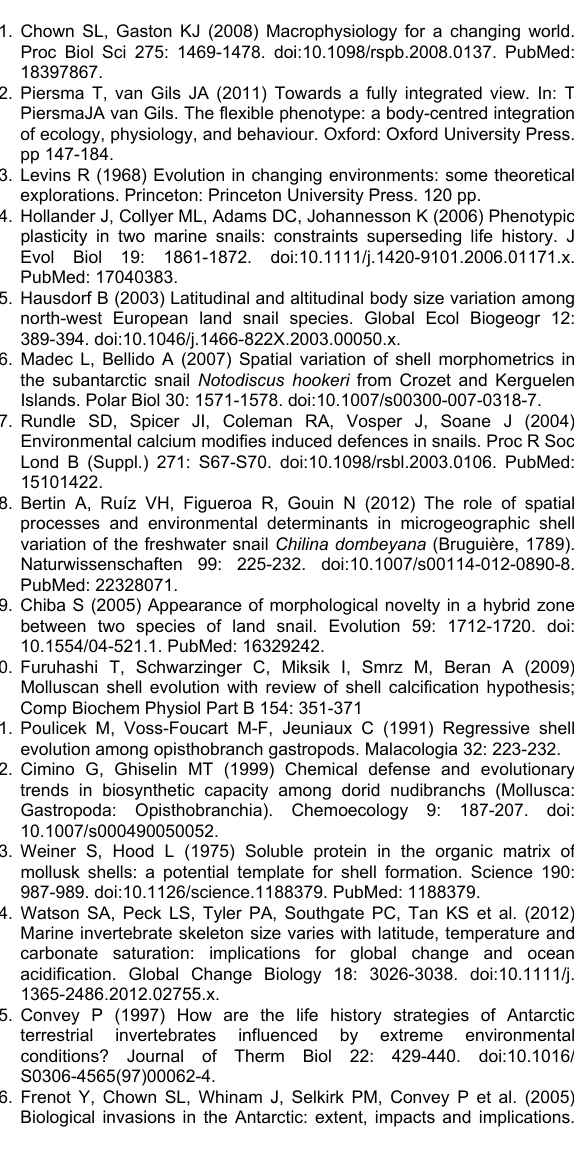
Figure S5. { 1 H} 13 C CPMAS spectrum of the organic layer of Notodiscus hookeri shells. Shells originated from Malpassée (MAL) were compared with those from Branca (BRA) and put in relation to the spectra of ß-chitin powder and of the most abundant L-amino acids found in this layer (G = glycine, L = leucine, I = isoleucine and V = valine). For other explanations, see Figure